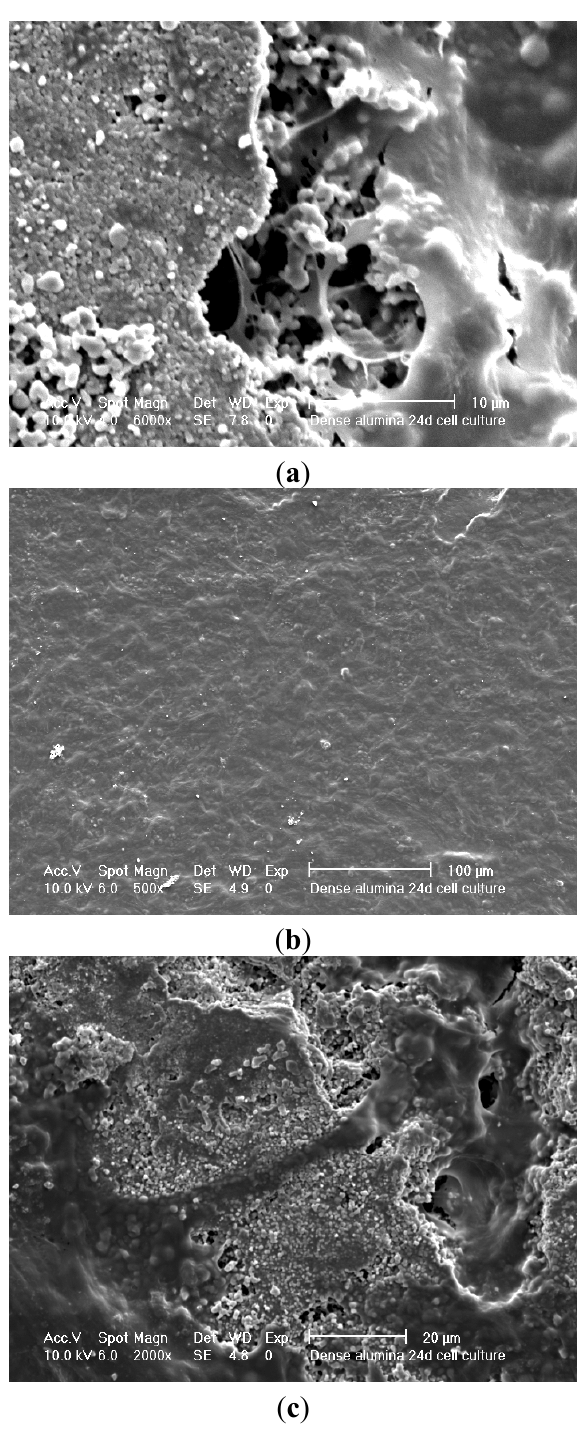
Figure 13. SEM micrographs of 24d culture on less porous alumina Sample B; ( a ) cells attaching in porous region; ( b ) confluent layer on ceramic surface; ( c ) cells connecting through a channel over the ceramic